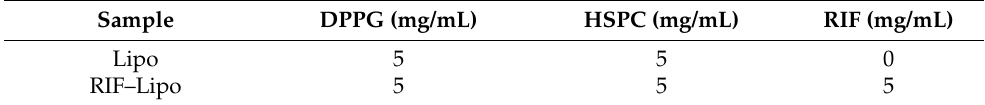
Table 1. Sample composition of empty liposomes (Lipo) and RIF-loaded liposomes (RIF–Lipo). Sample DPPG (mg/mL) HSPC (mg/mL) RIF (mg/mL) Lipo 5 5 0 RIF–Lipo 5 5 5 Errors are within